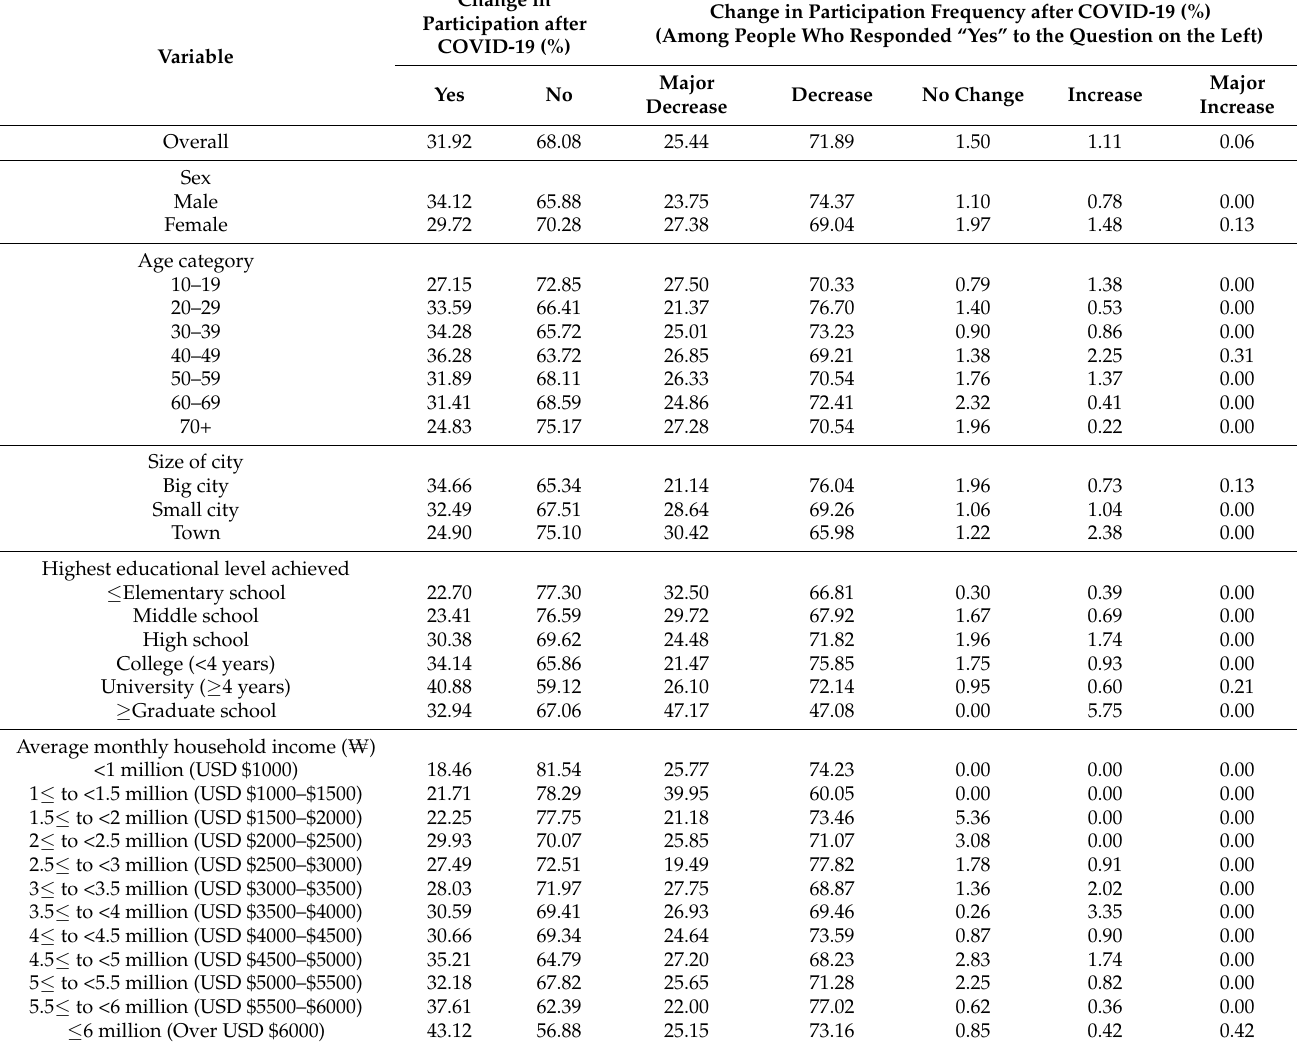
Table 4. Changes in participation in sports activities due to the COVID-19